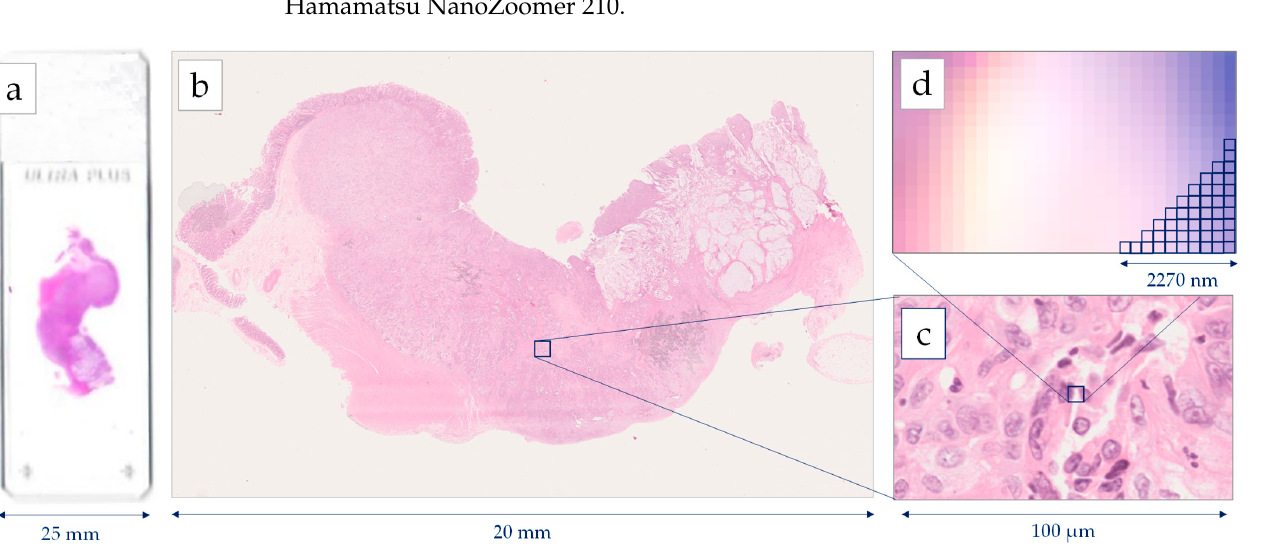
Figure 1. Image generation using a Hamamatsu NanoZoomer whole slide scanner: ( a ) histological slide 75 mm × 25 mm, ( b ) Whole Slide Image (WSI), ( c ) cell level in 40× magnification, ( d ) pixel level in 40× magnification digitizing images 227 nm per pixel.